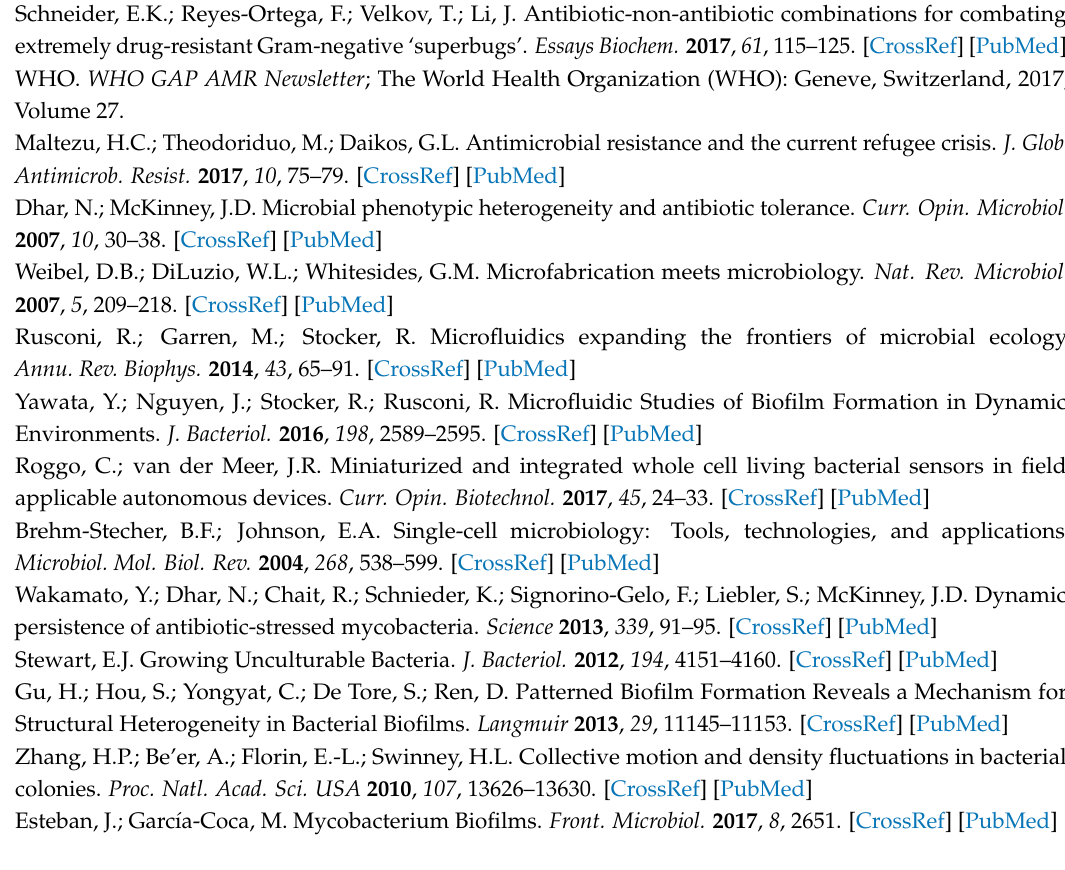
s1. Figure S1: mRNA expressions for M. smegmatis msm0031 transposon mutant. Bars represent the ratio of mRNA levels relative to sigA, a constitutive gene whose expression remains relatively unchanged. Number of transcript copies determined by qRT-PCR using gene-specific primers as listed below. Figure S2: Chromosomal locus encoding the msm0031 gene in M. smegmatis . Location of the transposon insertion indicated by vertical arrow. Figure S3: Confirmation for the msm0031 deletion mutant measuring the mRNA expression levels. Bars represent the ratio of mRNA levels relative to sigA, a constitutive gene whose expression remains relatively unchanged. Number of transcript copies determined by qRT-PCR using gene specific primers as listed in materials and methods. The RT-qPCR experiments were performed at least 2 times. Figure S4: Deletion of msm0031 gene altered morphology and growth rate. Deletion of msm0031 gene affected colony morphology (A), limited growth in standard 7H9 broth (B). Bright field images showed PBPA-inactivated cells were longer (C). Fluorescence microscopy of msm0031 deletion mutant transformed with Wag31–GFP showed defective septum formation in the presence of INH (D). Using time-lapse movies generation time was calculated as 3 hours for the msm0031 deletion cells (E). The measured cell area for the msm0031 deletion strain was 2 times larger than WT (F). Figure S5: Batch culture drug-killing assays for the msm0031 deletion mutant. WT M. smegmatis and the msm0031 deletion mutant were treated with INH-50 µ g/mL (A), ETH-200 µ g/mL (B), EMB-5 µ g/mL (C), and RIF-200 µ g/mL (D). Serial dilutions of cultures were plated at the indicated time points to determine the CFU count. INH and EMB results are the mean ± standard error from 3 independent cultures; ETH and RIF results are the mean ± standard error from 3 independent cultures. Figure S6: Growth curves for the complemented msm0031 transposon and deletion strains. Growth was monitored by measuring culture turbidity (OD 600 nm) at the indicated time points. Figure S7: Batch culture drug-killing assays for the complemented msm0031 deletion and transposon strains. WT M. smegmatis , the complemented msm0031 deletion and complemented msm0031 transposon mutant were treated with INH-50 µ g/mL (A), ETH-200 µ g/mL, (B), EMB-5 µ g/mL (C), and RIF-200 µ g/mL (D). Serial dilutions of cultures were plated at the indicated time points to determine the Log CFU. The results are representatives at least two independent experiments. Video S1: PBP